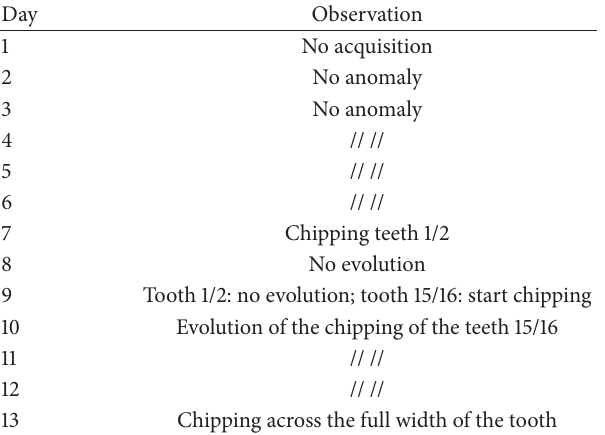
Table 4: Daily mechanical